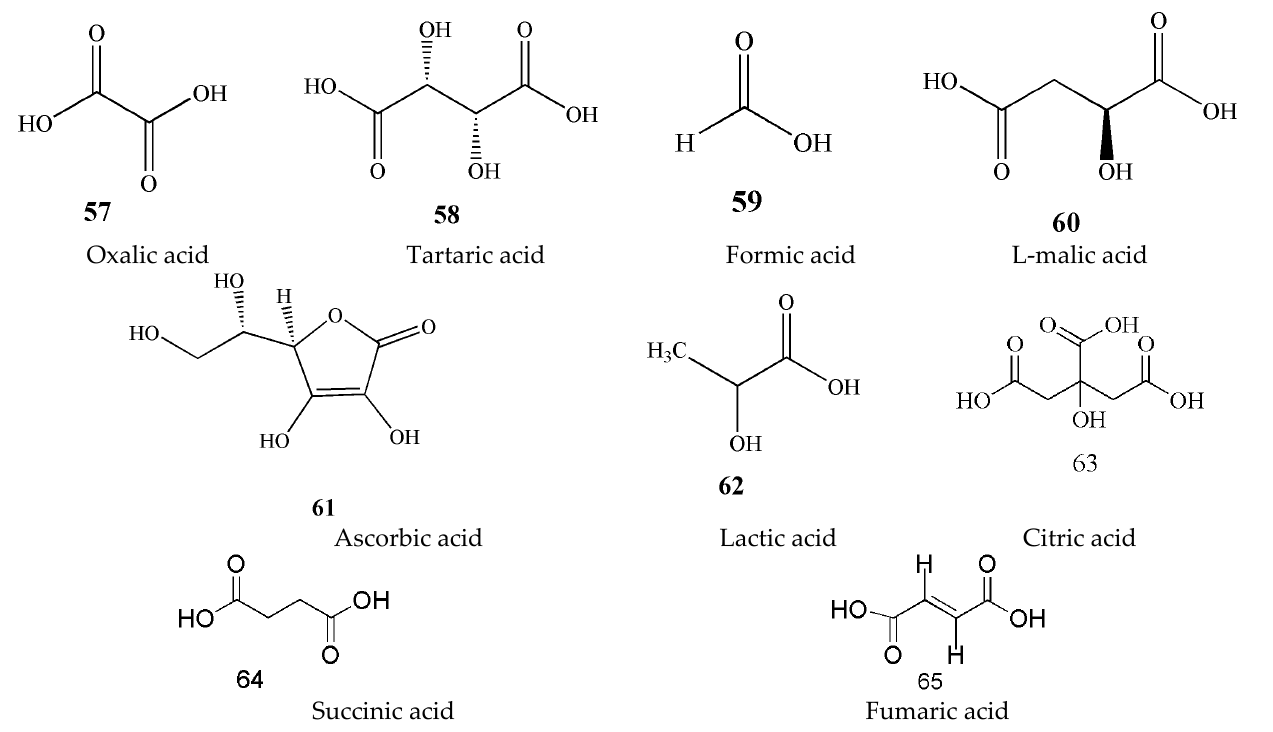
Figure 8. Chemical structures of organic acids isolated from green tea.